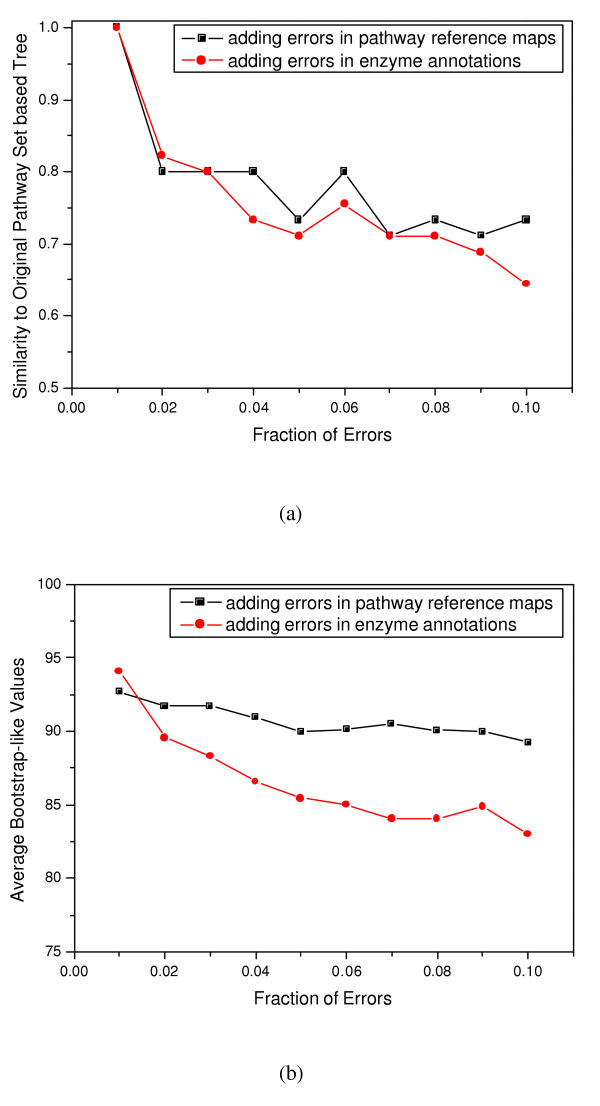
Robustness testing. (a) Similarities between consensus pathway set based trees and the original one. (b) Average bootstrap-like values of consensus pathway set based trees.